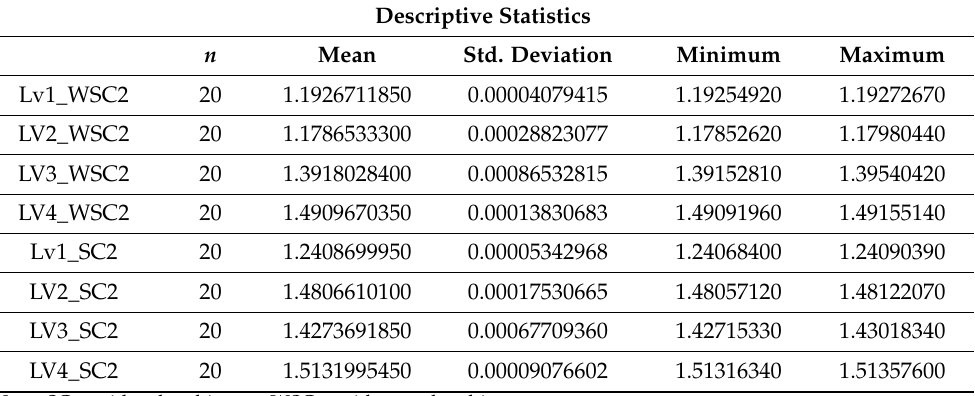
Table 6. The mean and standard deviation in the air velocities measured across all 4 simulated sce- narios.